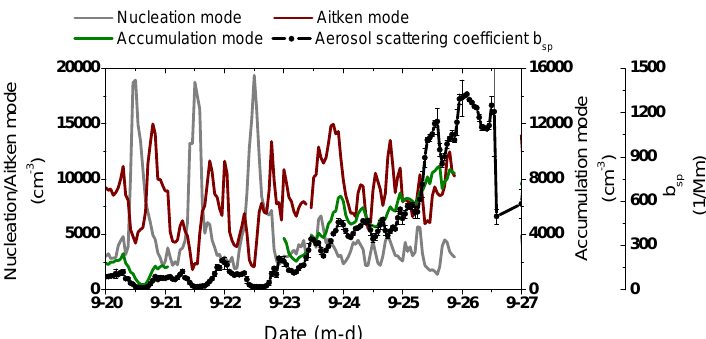
Fig. 10. Temporal variations of the measured aerosol scattering coefficient b sp and aerosol number concentrations for nucleation mode, Atiken mode, and accumulation mode.